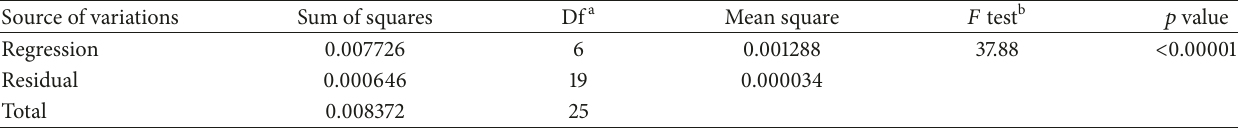
Table 5: Analysis of variance (ANOVA) of the predictive model obtained for growth rate according to the CCRD. Source of variations Sum of squares Df